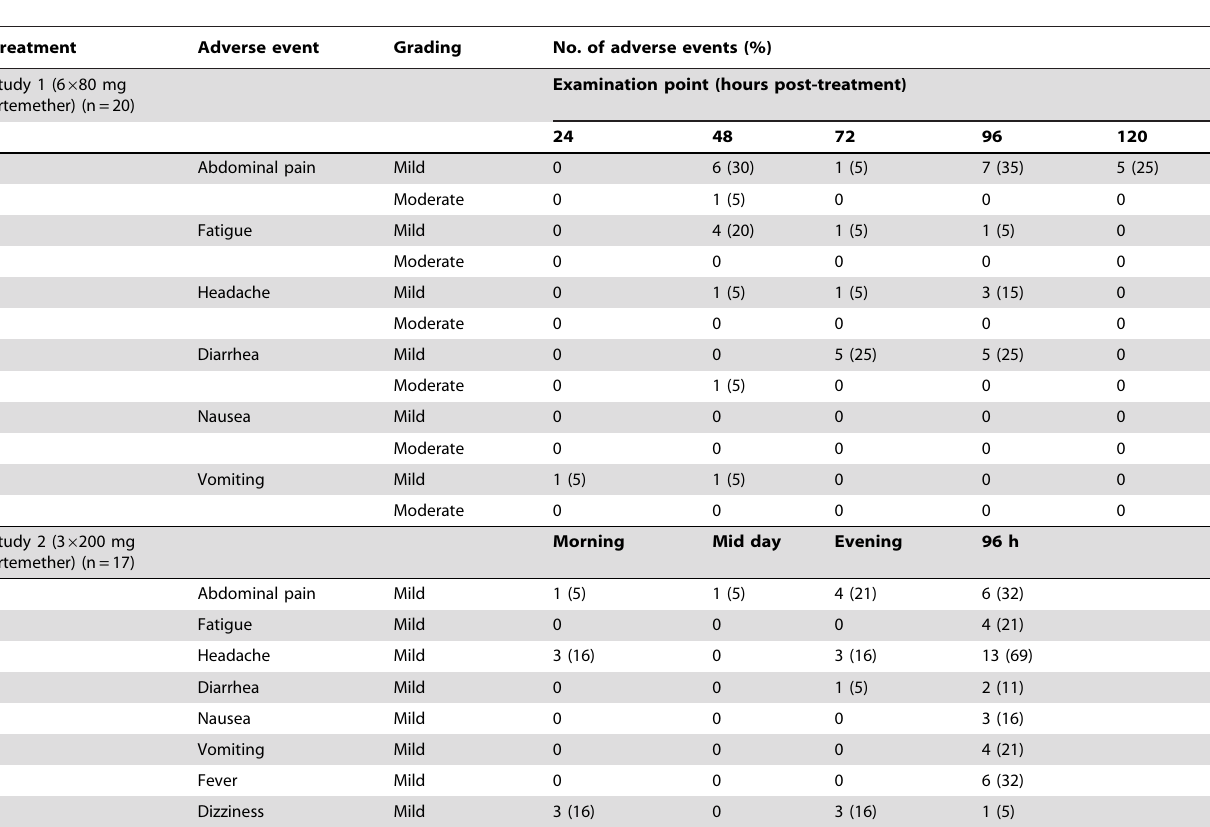
Table 5. Treatment related adverse events observed in patients receiving